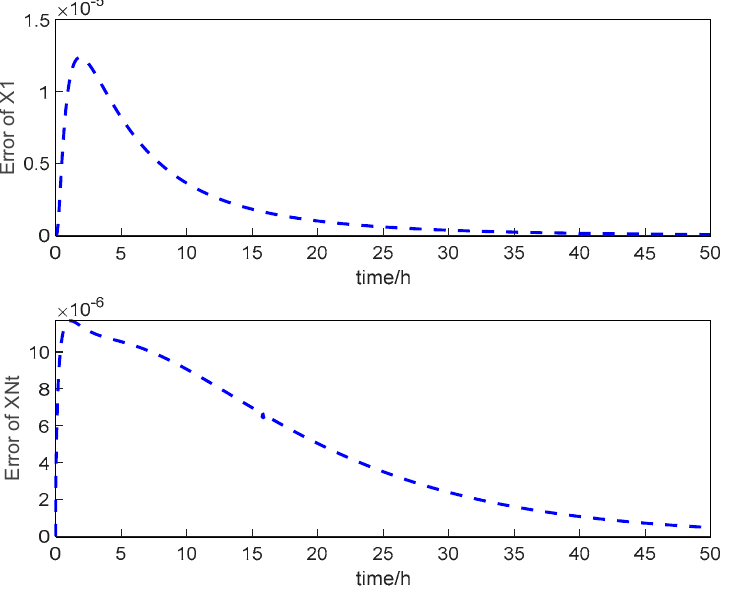
Figure 6. Concentration distribution curve of distillation column in steady state.